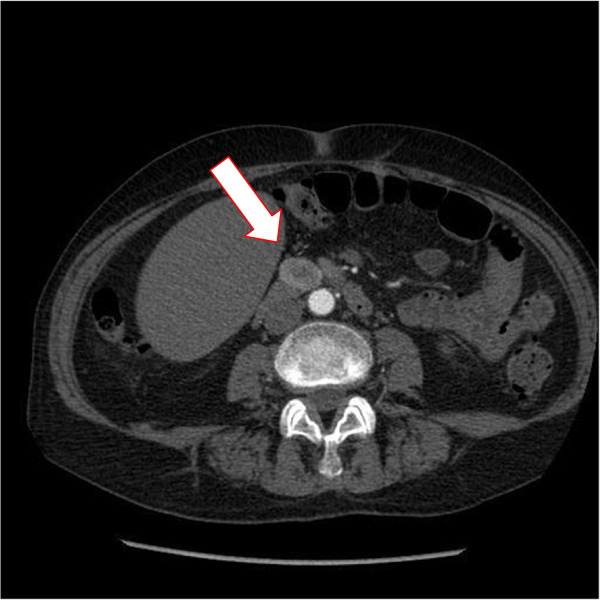
Abdominal CT scan showing a 2-cm, contrast-enhanced mass (arrow) in the uncinate process of the pancreas.